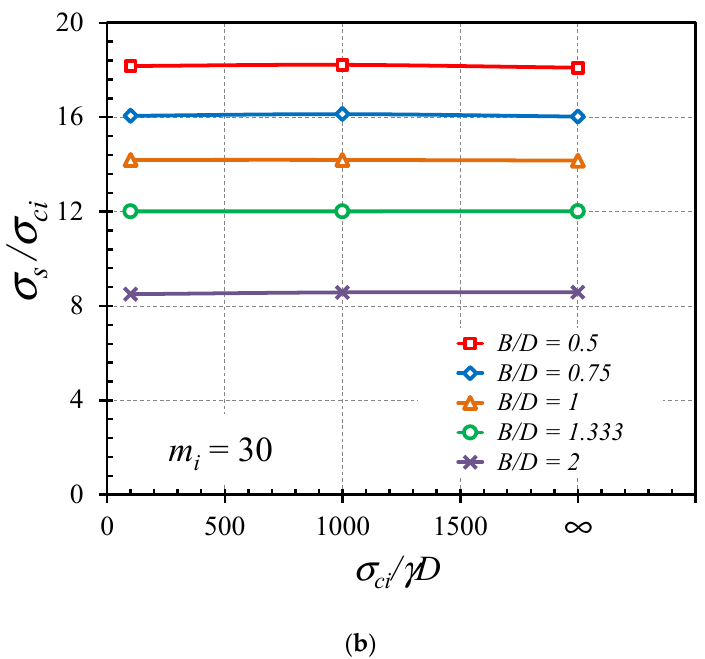
Figure 6. Impact of σ ci / γ D on σ s / σ ci of horseshoe tunnels with C / D = 3 and GSI = 80: ( a ) m i = 5 and ( b ) m i = 30.